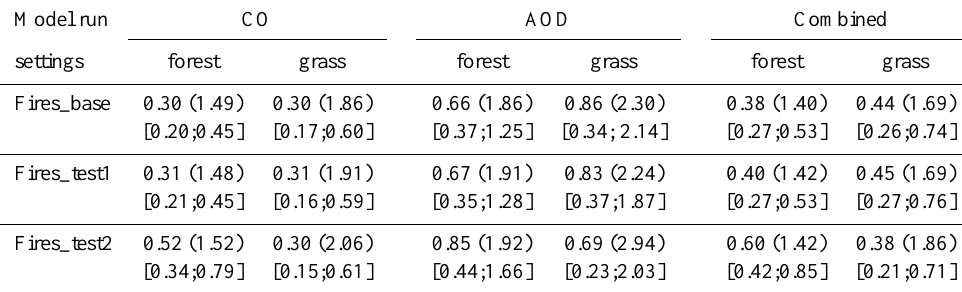
Table 2. Estimates of the FRP-to-BBR conversion factors (kgMJ − 1 ) for forest and grass (including agricultural) fires. The estimates derived independently from CO and AOD measurements by using the different model run settings are shown along with the combined optimal estimates. The geometric standard deviations characterizing uncertainties and the corresponding uncertainty ranges are given in round and square brackets,